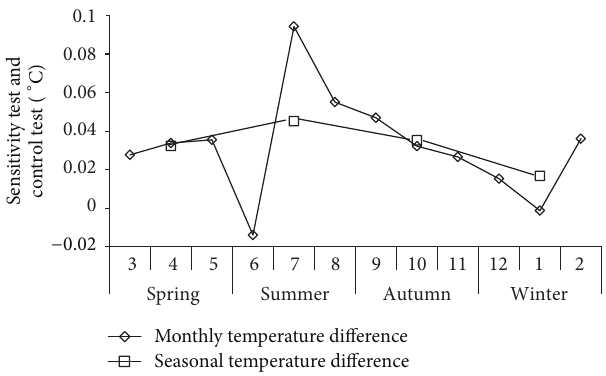
Figure 7: Monthly and seasonal temperature differences in the control test and sensitivity